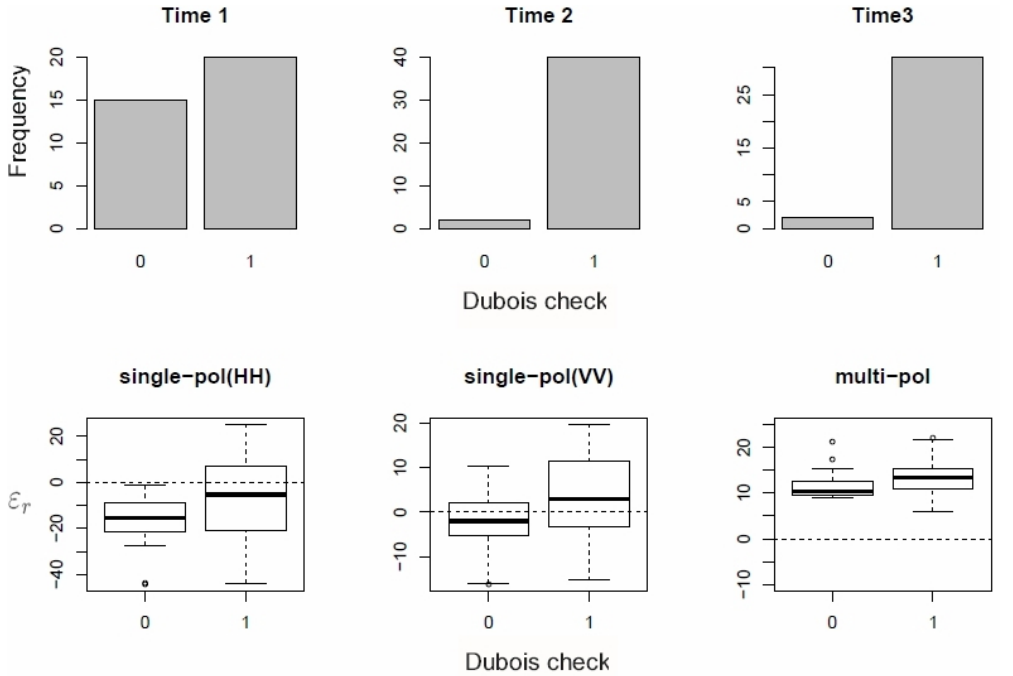
Figure 4. Box-plot summaries of the distribution of ε Conditions (denoted by 1) or not (denoted by 0). In the bottom panels, we observe that even when the Dubois conditions hold, a changing proportion of data yield negative values of the dielectric